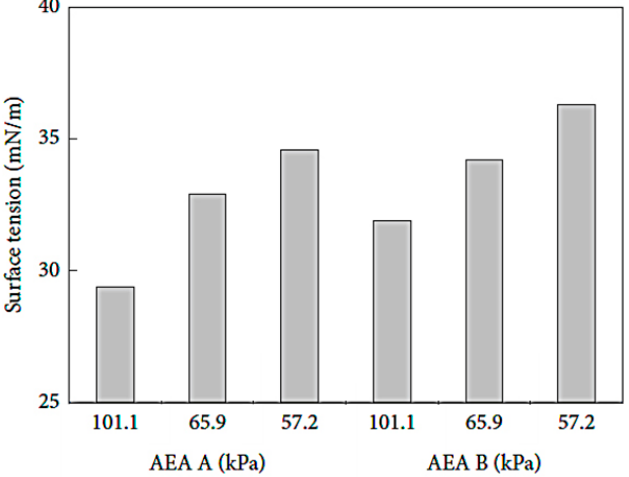
Figure 3. Surface tension histogram of air entraining agent (AEA) under different atmospheric pressure (AP).